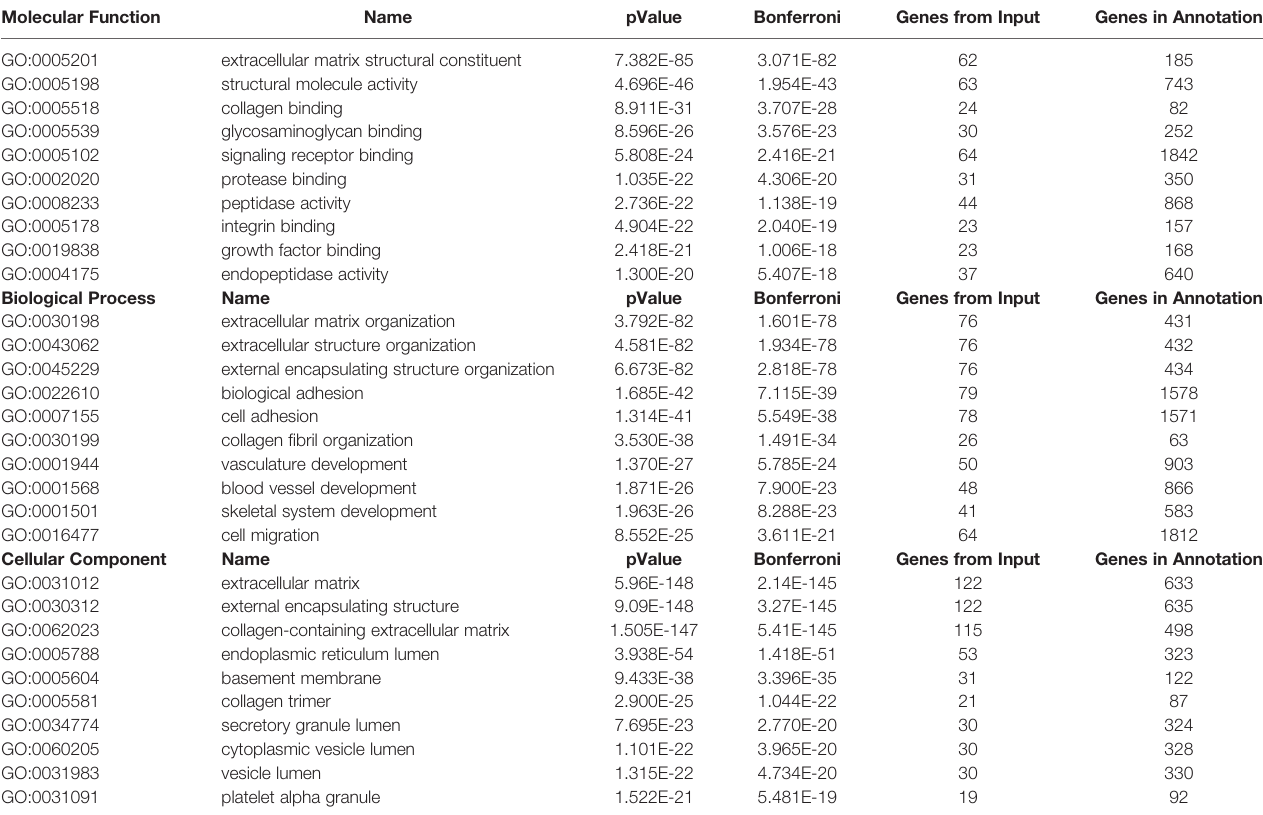
TABLE 2 | Most enriched GO terms: molecular function, biological process, cellular component. Molecular Function